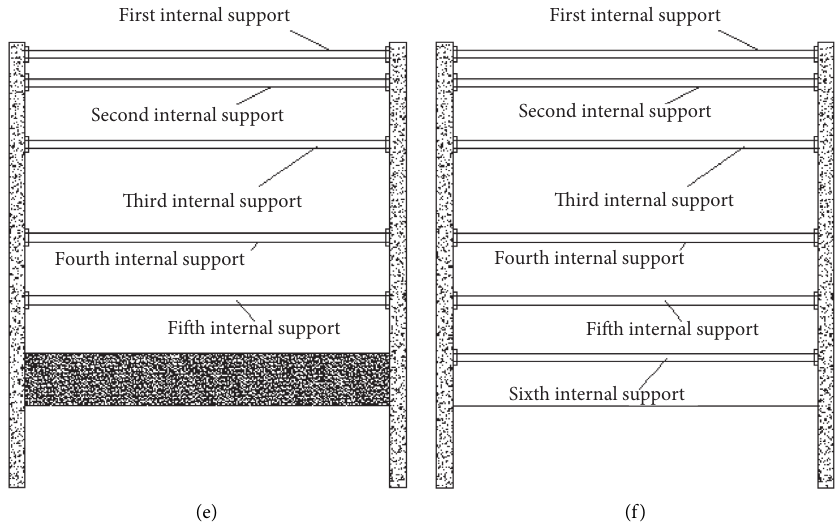
Figure 10: Construction condition. (a) Working condition 1. (b) Working condition 2. (c) Working condition 3. (d) Working condition 4. (e) Working condition 5. (f) Working condition 6.